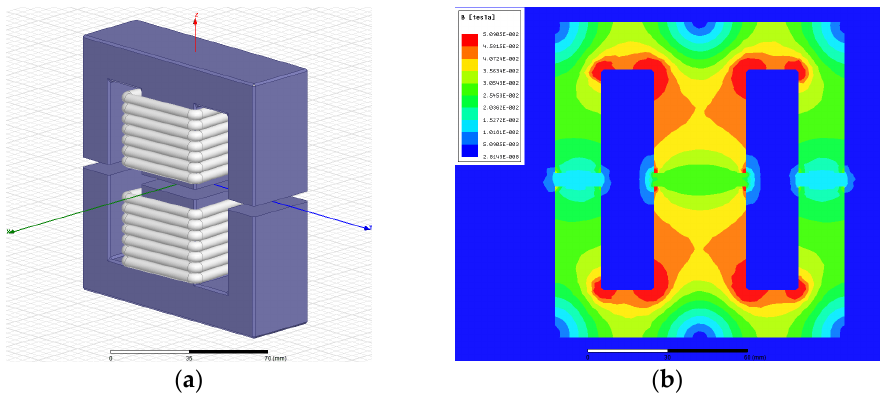
Figure 7. Decoupled transformers: ( a ) the model established in MAXWELL; ( b ) Magnetic field distribution.